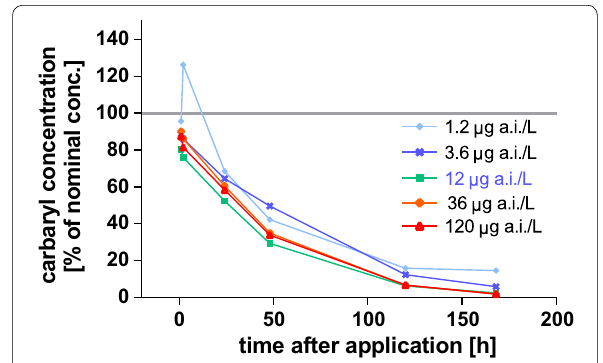
Fig. 2 Dissipation of carbaryl in the stream